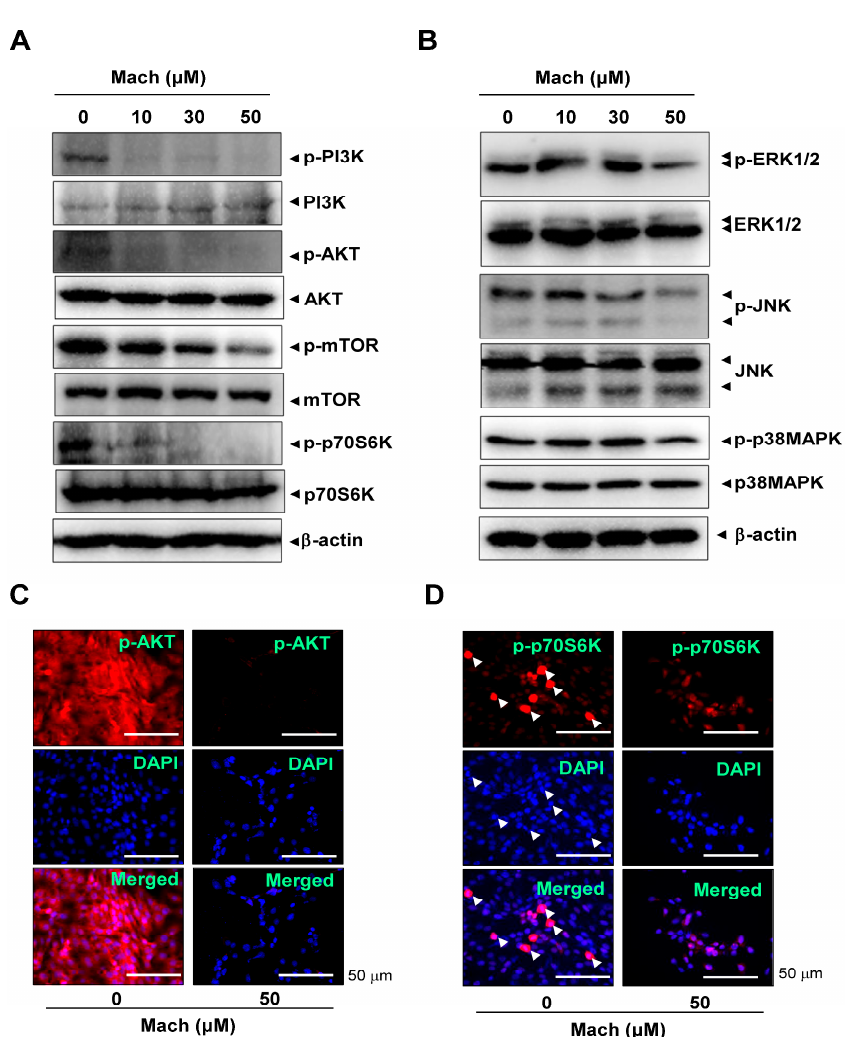
Figure 4. Effects of Mach on the PI3K/AKT/mTOR/p70S6K and MAPKs pathways in human YD-10B OSCC cells. ( A ) Western blotting of phospho-PI3K (p-PI3K), PI3K, phospho-AKT (p-AKT), AKT, phospho-mTOR (p-mTOR), mTOR, phospho-p70S6K (p-p70S6K), p70S6K, and -actin levels. ( B ) Western blotting of phospho-ERK1/2 (p-ERK1/2), ERK1/2, phospho-JNK (p-JNK), JNK, phospho-p38 (p-p38) MAPK, p38 MAPK, and β -actin levels. ( C , D ) Immunofluorescence assay to assess phosphorylation levels of AKT ( C ) and p70S6K ( D ) in YD-10B OSCC cells. Images were captured using a microscope. Nuclei were stained with DAPI (blue). Scale bar: 50 μ m. Data are representative